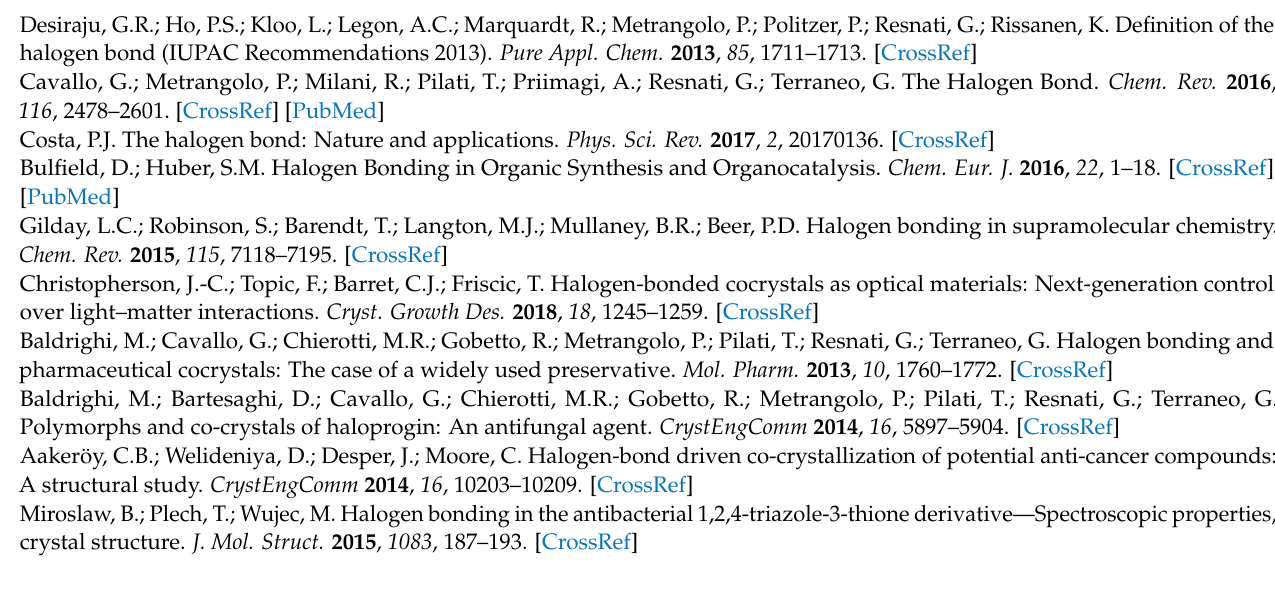
1,2,4,5-tetrafluoro-1,3-diiodobenzene (TFDIB) and the mixtures prepared in methanol (MT) or water (WA) and the different ratios used. Figure S3. Comparison of the powder patterns of uracil (URA), 1,2,4,5-tetrafluoro-1,3-diiodobenzene (TFDIB) and the mixtures prepared in methanol (MT) or water (WA) and the different ratios used. Figure S4. Comparison of the powder patterns of cytosine (CYT), 1,2,4,5-tetrafluoro-1,3-diiodobenzene (TFDIB) and the mixtures prepared in methanol (MT), water (WA) or nitromethane (NM) and the different ratios used. Table S1. Melting points and solubilities in water of canonical nucleobases. Figure S5. Comparison of ATR-FT-IR spectra of thymine, 1,2,4,5- tetrafluoro-1,3-diiodobenzene (TFDIB) and cocrystal 1. Figure S6. Comparison of ATR-FT-IR spectra of 1-ethyluracil, 1,2,4,5-tetrafluoro-1,3-diiodobenzene (TFDIB) and cocrystal 2. Figure S7. Comparison of ATR-FT-IR spectra of 5-fluorouracil, 1,2,4,5-tetrafluoro-1,3-diiodobenzene (TFDIB) and cocrystal 3. Table S2. Some characteristic frequencies for the modified uracil compounds, the coformer and the new cocrystals. Figure S8. TGA-DSC of the cocrystal 1. Figure S9. TGA-DSC of the cocrystal 2. Figure S10. TGA-DSC of the cocrystal 3. Figure S11. X-bonds angles in cocrystals 1-3. Table